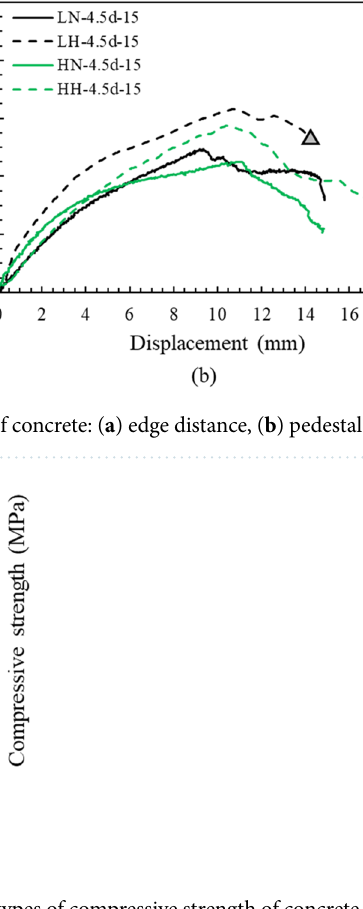
Figure 11. Comparison of maximum shear force due to two types of compressive strength of